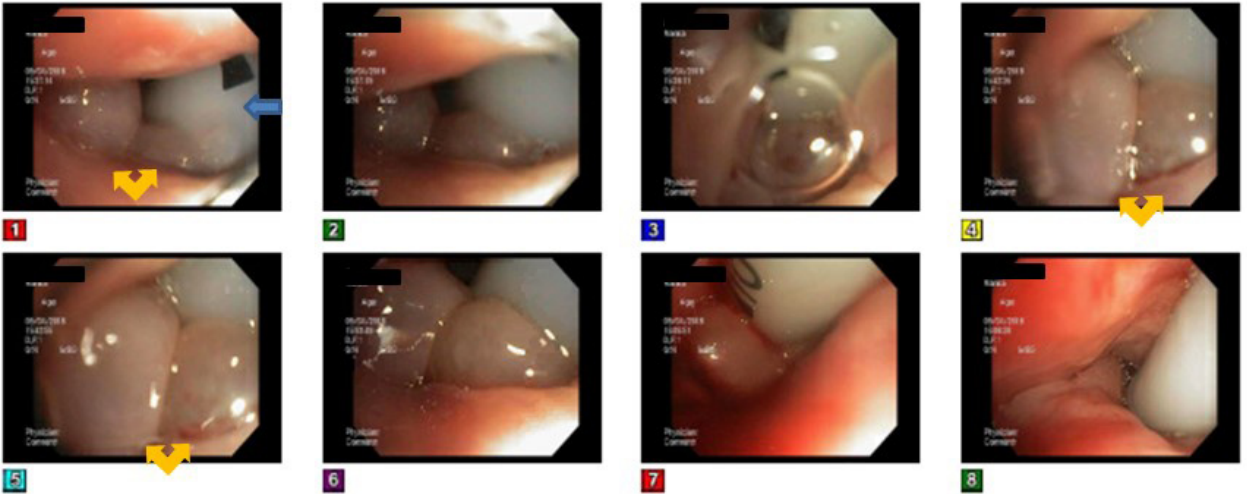
Figure 2. Video bronchoscopy images showing enlarged arytenoid appendages (yellow arrows). Endotracheal tube (blue arrow) can be seen entering the vocal